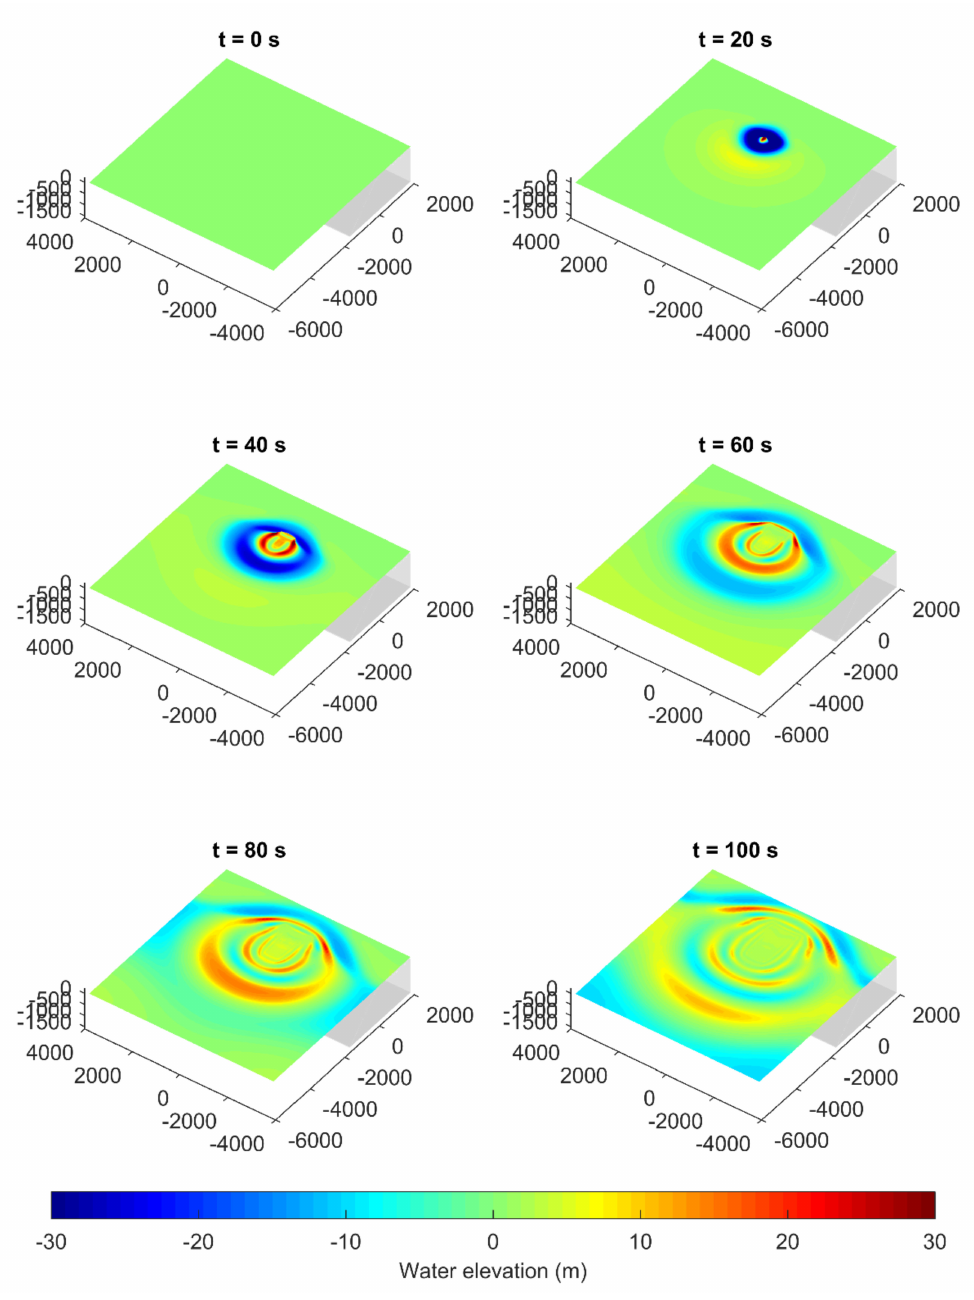
(cid:16) (cid:17) µ µ τ = y B , A ,